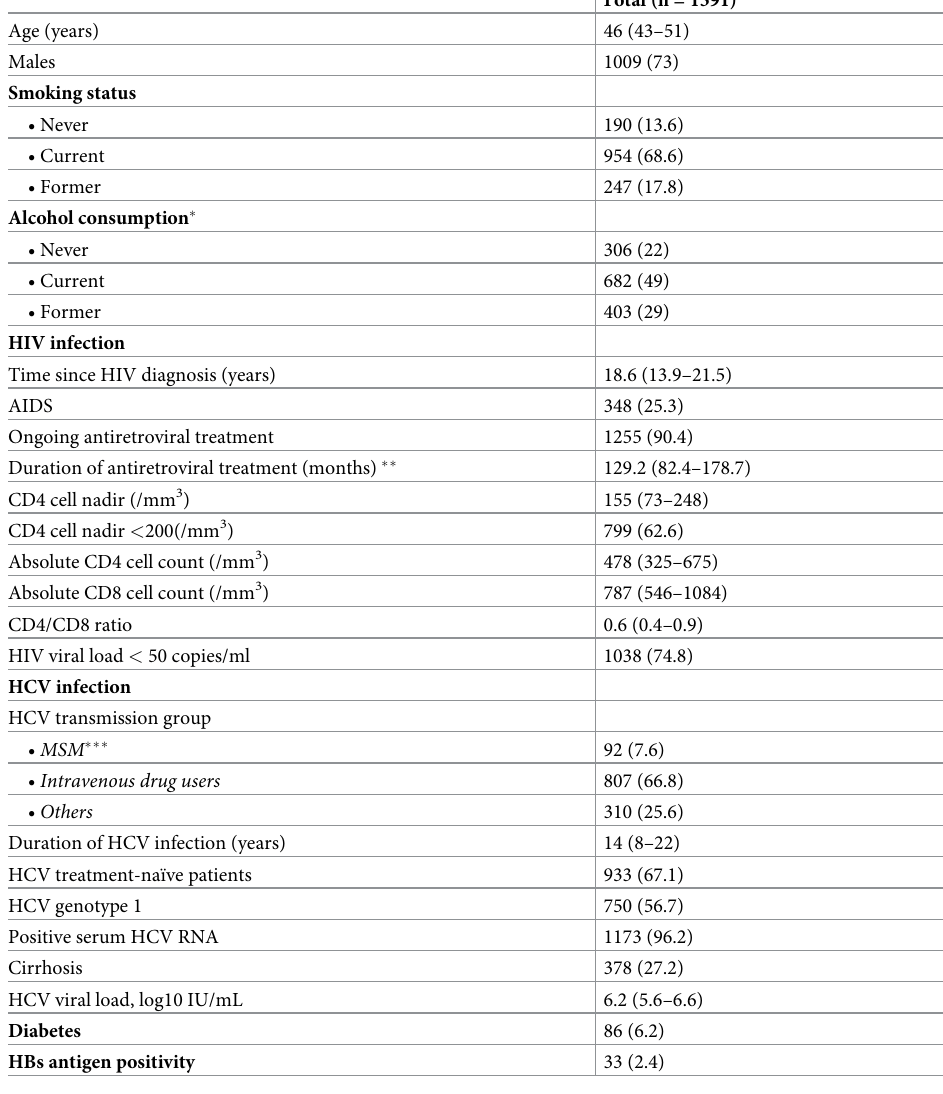
Table 1. Baseline characteristics of the 1391 HIV/HCV-coinfected patients from the ANRS CO13 HEPAVIH cohort; results are medians (IQR) or numbers